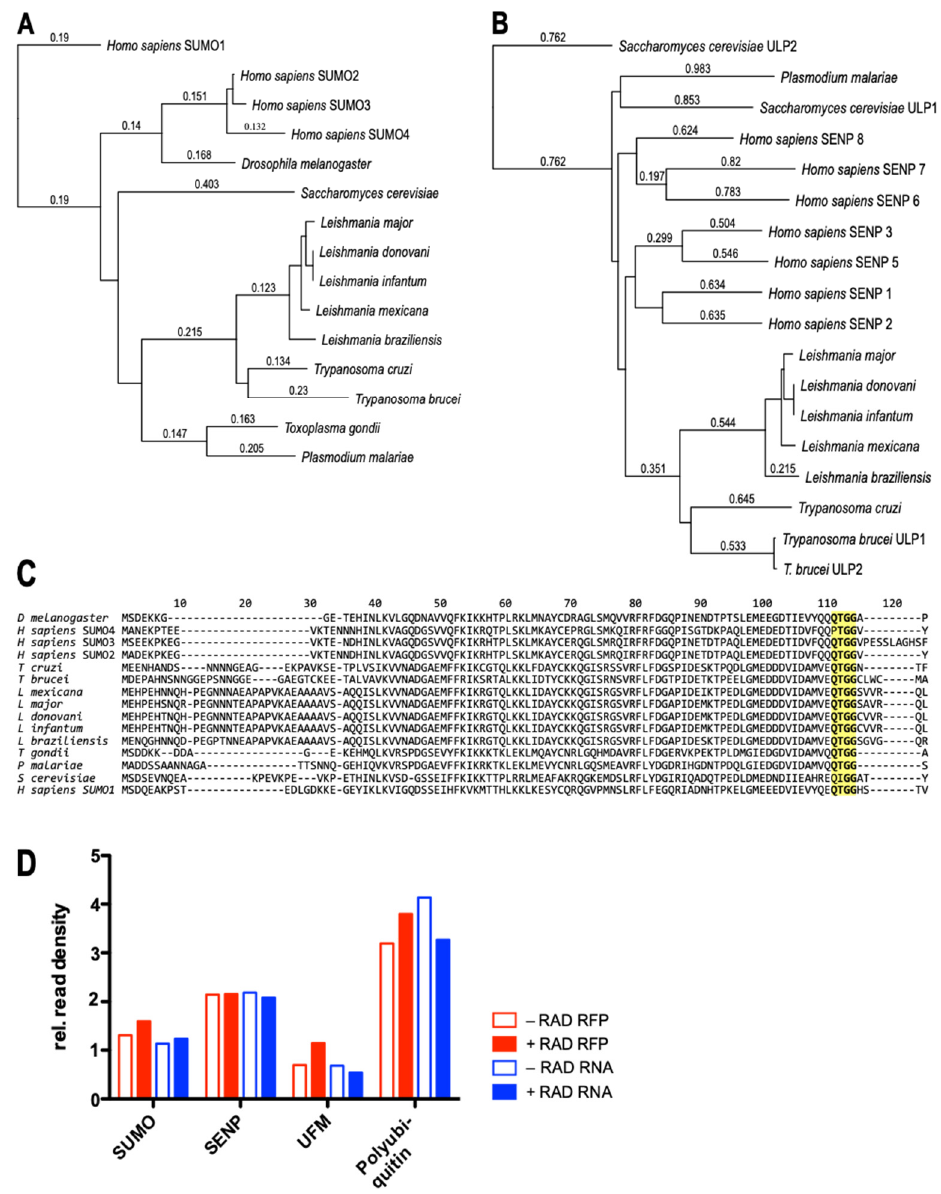
Figure 1. Conservation and expression of SUMO and SENP in Leishmania . ( A ) Phylogenetic analysis of SUMO proteins. Sequence alignment and tree building were done using the neighbor joining algorithm and best-fit analysis with Poisson correction. Numbers indicate amino acid sequence deviation. ( B ) Phylogenetic analysis of SENP proteins, performed as in ( A ). ( C ) Alignment of SUMO amino acid sequences, with the C-terminal di-glycine highlighted. ( D ) Gene expression analysis by ribosome profiling and RNA-seq analysis for L. donovani before ( − RAD) and after ( + RAD) radicicol-induced di ff erentiation. Shown are relative read densities, normalized to the median read densities, for protein synthesis (RFP) and RNA abundance (RNA). Data collected from